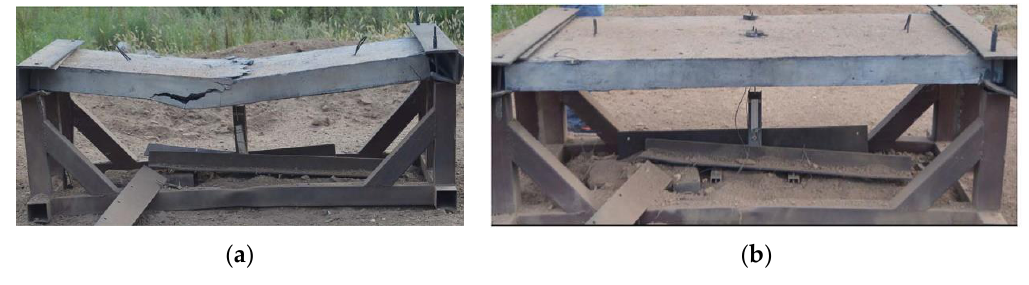
Figure 2. The detonation of ( a ) normal concrete; ( b ) PE-ECC [91].